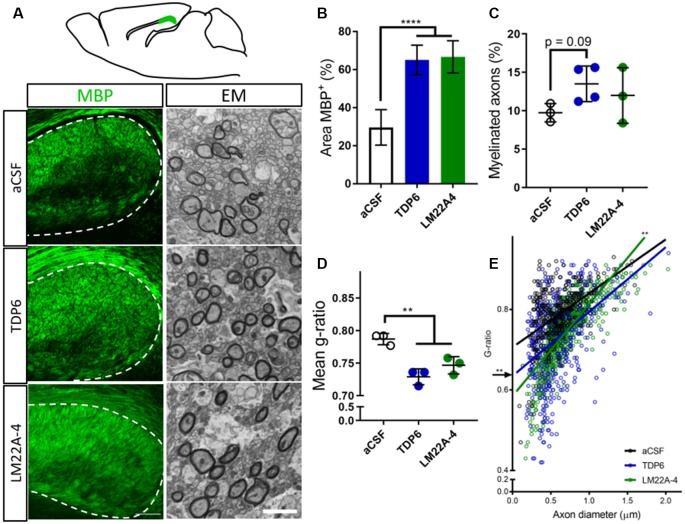
Brain-derived neurotrophic factor (BDNF)-structural mimetic, tricyclic dimeric peptide-6 (TDP6) and tropomyosin-related kinase (Trk) B agonist, LM22A-4 increase myelin sheath thickness during remyelination in after cuprizone demyelination. (A) Schematic of a sagittal brain section 0.36 mm lateral from midline. Adapted from Paxinos and Franklin (2001); caudal region of the corpus callosum analysed shaded green (above). Representative myelin basic protein (MBP) immunostatining (sagittal plane, scale bar = 100 μm) and electron micrographs (scale bar = 2 μm) of the cadual corpus callosum of artificial cerebrospinal fluid (aCSF) vehicle, TDP6 and LM22A-4 treated cuprizone demyelinated mice (below). (B) Percentage of MBP staining increased (p < 0.0001) in TDP6 and LM22A-4 treated mice compared to those that received aCSF vehicle (n = 4–8/group). (C) The proportion of axons remyelinated trended towards increasing with TDP6 treatment (p = 0.09) compared to aCSF, but was unchanged between aCSF and LM22A-4 (p = 0.48) and LM22A-4 and TDP6 (p = 0.31, n = 3–4/group), however (D) the mean g-ratio was decreased (p = 0.002) in both TDP6 and LM22A-4 treated mice, indicative of thicker myelin sheaths compared to those receiving aCSF vehicle (n = 3/group). (E) Scatter plot of g-ratio against axonal diameter. Linear regression revealed that TDP6 treatment resulted in a decrease in y-intercept (p = 0.0032) but no change in slope (p = 0.35), while LM22A-4 treatment increased slope (p = 0.0061), both indicative of increased myelin sheath thickness compared to aCSF treatment (n = 3 mice/group, min. Hundred axons/animal). One-way analysis of variance (ANOVA) with Tukey’s post hoc comparisons, p < 0.05 considered significant. Mean ± SD plotted. Six-weeks cuprizone feeding commenced at 8 weeks of age, tissue collected at 15 weeks of age. **p < 0.01, ****p < 0.0001.